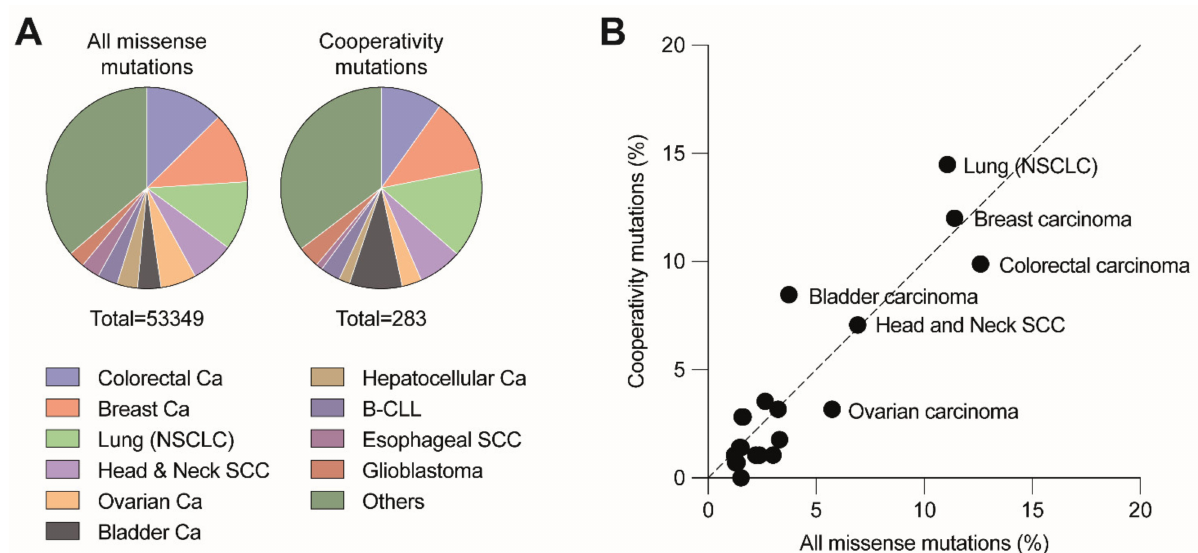
Figure 3. Distribution of cooperativity mutations across different cancer types. ( A ) Pie charts depict the distribution of all missense and cooperativity mutations across the listed cancer types. ( B ) Cancer type distribution of cooperativity mutations correlates with the distribution of all missense mutations ( R 2 = 0.8779, p < 0.001). Analysis based on all tumor samples with p53 missense mutations listed in the UMD TP53 Mutation Database (https://p53.fr/tp53-database, Release 2017_R2, accessed on 12 May